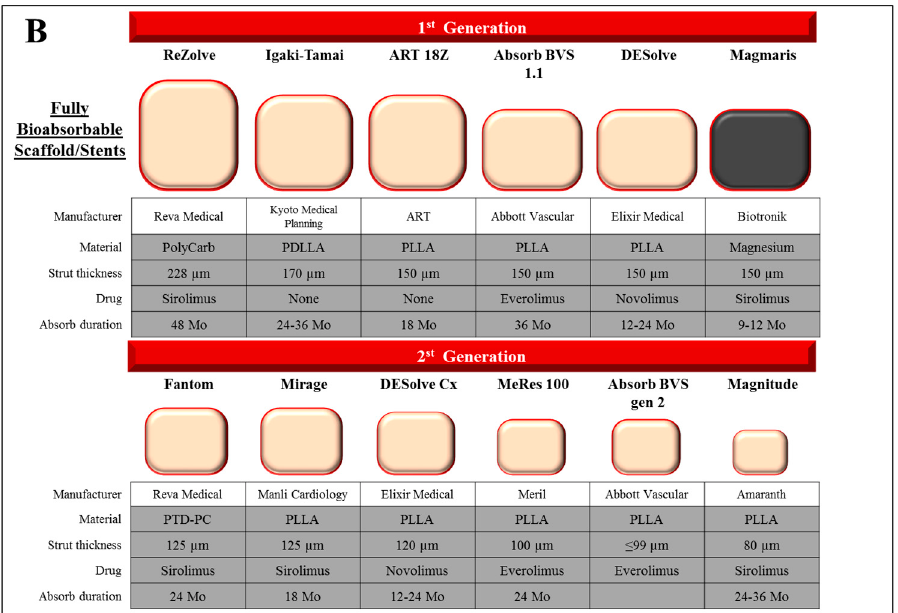
Figure 2. Design characteristics of representative drug eluting stent and bioabsorbable scaffold/stent. ( A ) The characteristics of past and current commercial drug-eluting stents including durable polymer (DP)-, biodegradable polymer (BP)-, and polymer free-DES. Types of materials (alloy, drug, and polymer), strut thickness, and estimated duration for polymer absorption (in BP-DES) of each stent are described. ( B ) The characteristics of 1st and 2nd generation fully bioabsorbable scaffold/stents. Types of materials (polymer, alloy, and drug), strut thickness, and estimated duration